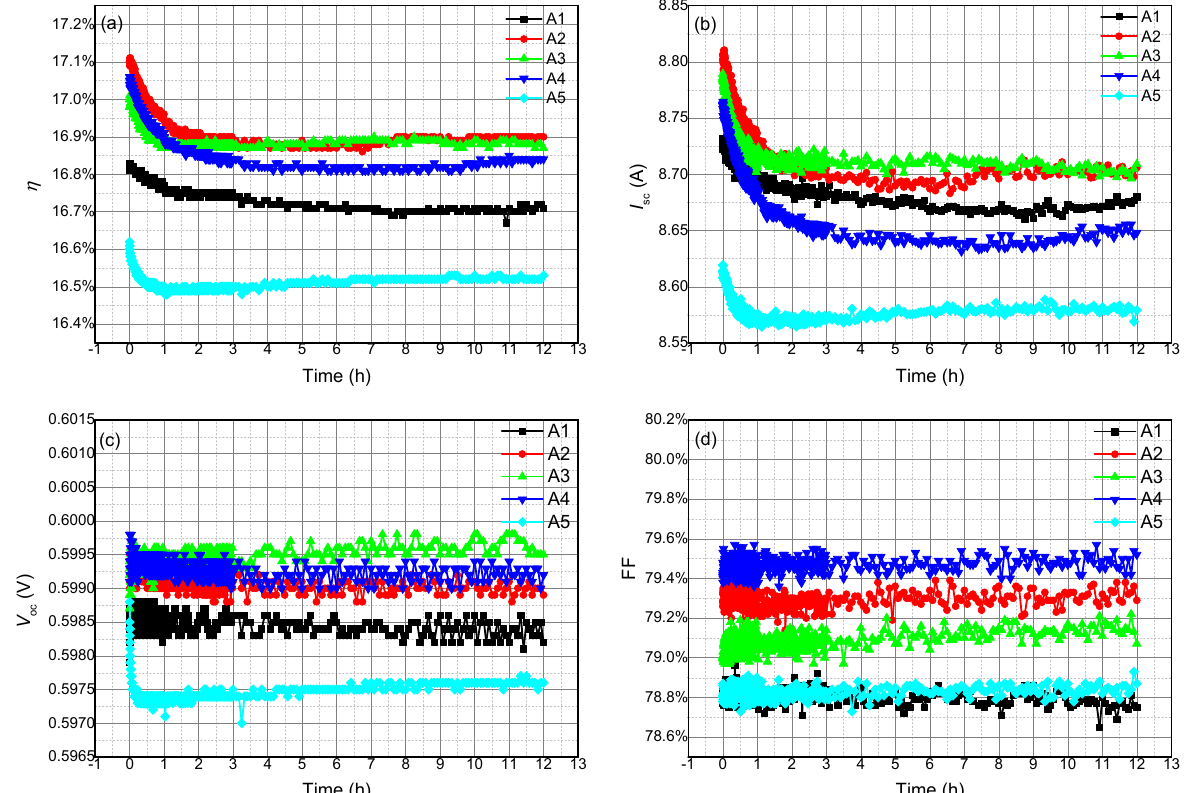
Figure 3. In-situ changes of illuminated I - V characteristic parameters of the five groups of Al-BSF solar cells with processing time within the 2nd LID (45 °C, 1 sun, 12 h). (a) efficiency; (b) short-circuit current; (c) open-circuit voltage; (d) fill factor.